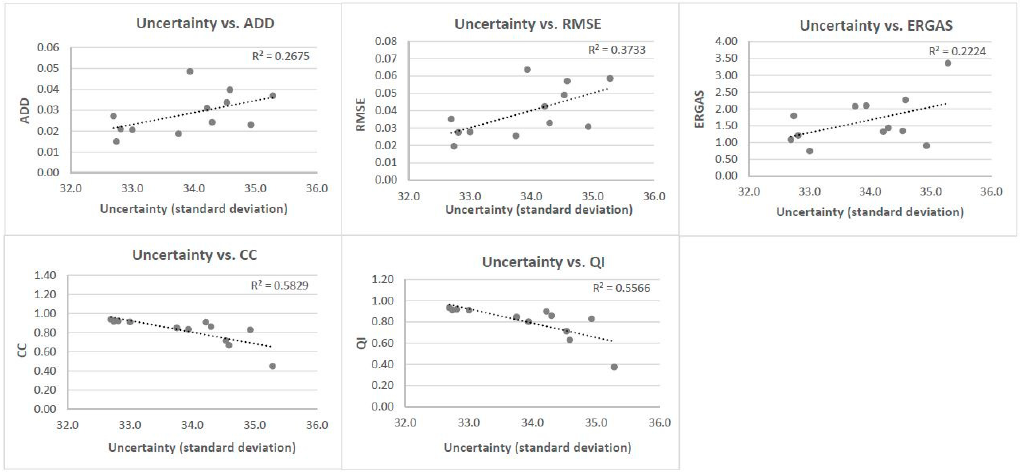
Figure 7. Uncertainty vs. Quality indices. Figure 8. Uncertainty vs. Quality